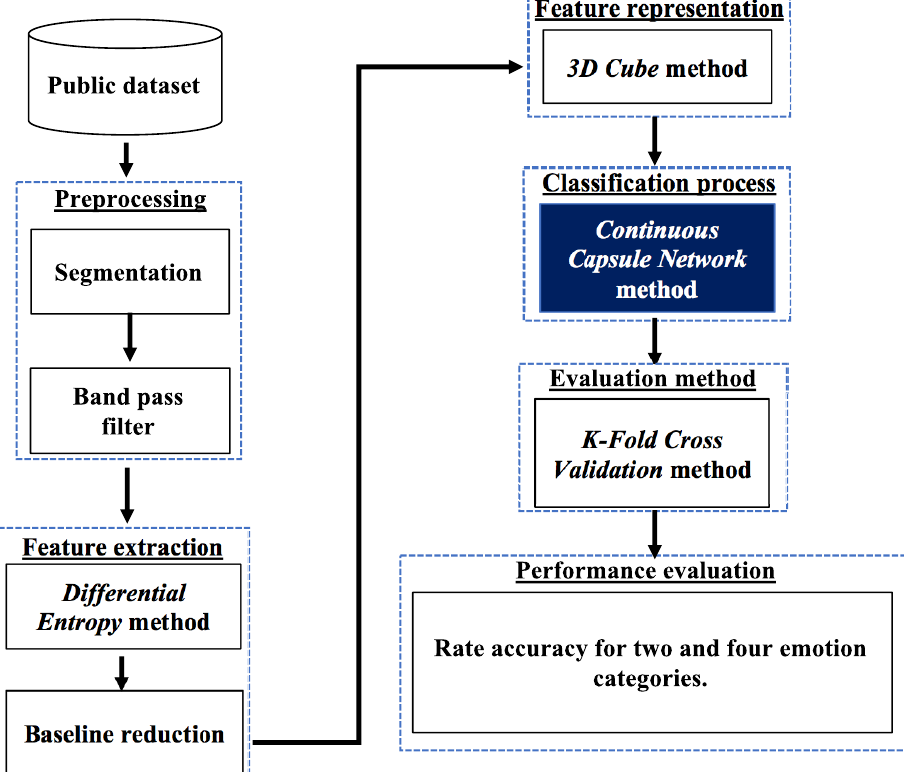
Figure 1. Steps of emotion recognition are based on EEG